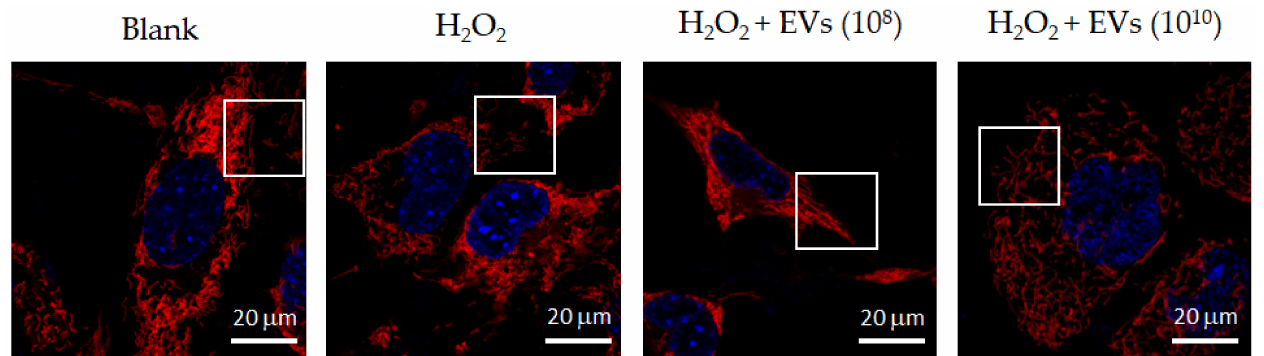
Figure 7. The promotion of Mfn-2 expression in H 2 O 2 -induced 3A-sub-E placental cells after treatment with L. crispatus -derived EVs (final concentration: 10 10 particles/mL) for 24 h. Data are expressed as mean ± SD (n = 3). Significant differences ( p < 0.05) are indicated by different letters (a,b) .